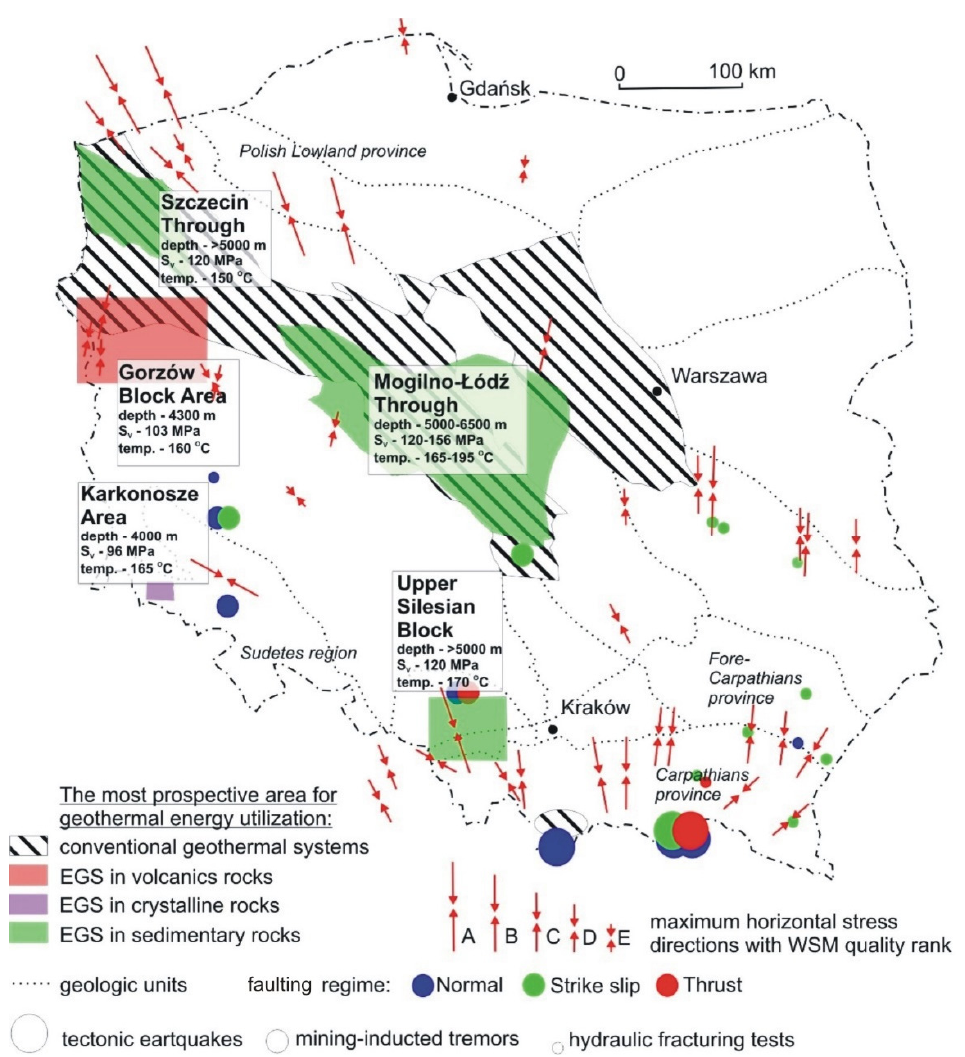
Figure 6. Prospective areas for geothermal energy utilization in enhanced geothermal systems in Poland. Explanation: σ V was calculated for given depth, based on average density of overlying rocks—2.4 g/cm 3 from [78]. Prospective areas were marked based on data from [74]. Horizontal stress directions and faulting regime were compiled from [75–77,86].